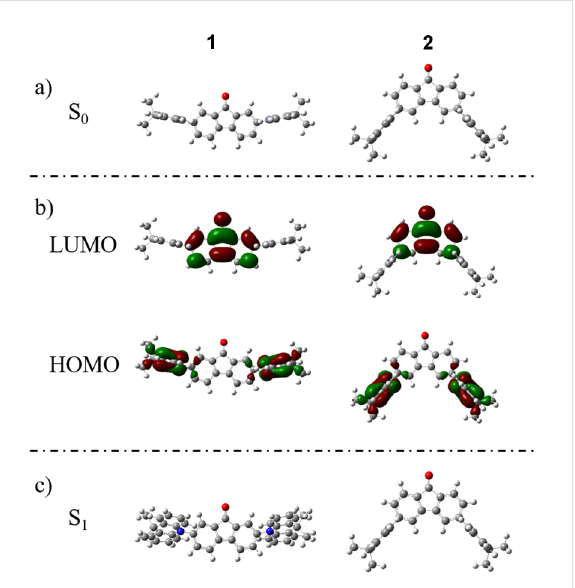
Figure 1: (a) The optimized S 0 geometries of 1 (left) and 2 (right) on B3LYP/6-31G* level in gas phase; (b) The frontier molecular orbital distributions of 1 and 2 ; (c) The optimized S 1 geometries in TD-DFT on m062x/6-31G* level.